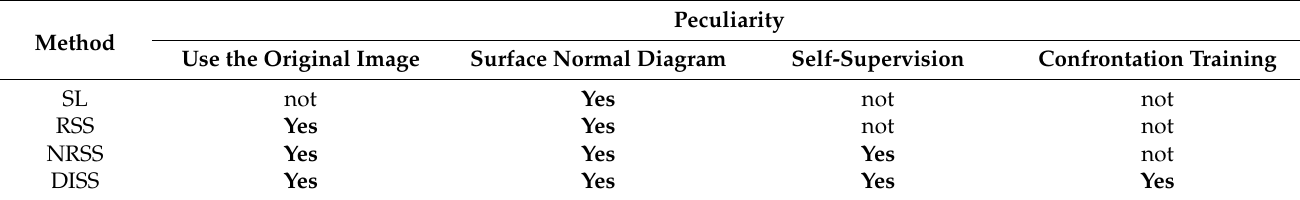
Table 1. Comparison of different methods in the